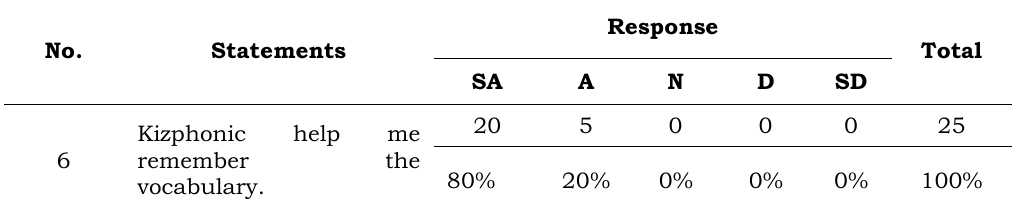
Table 8. Response to the questionnaire number 6